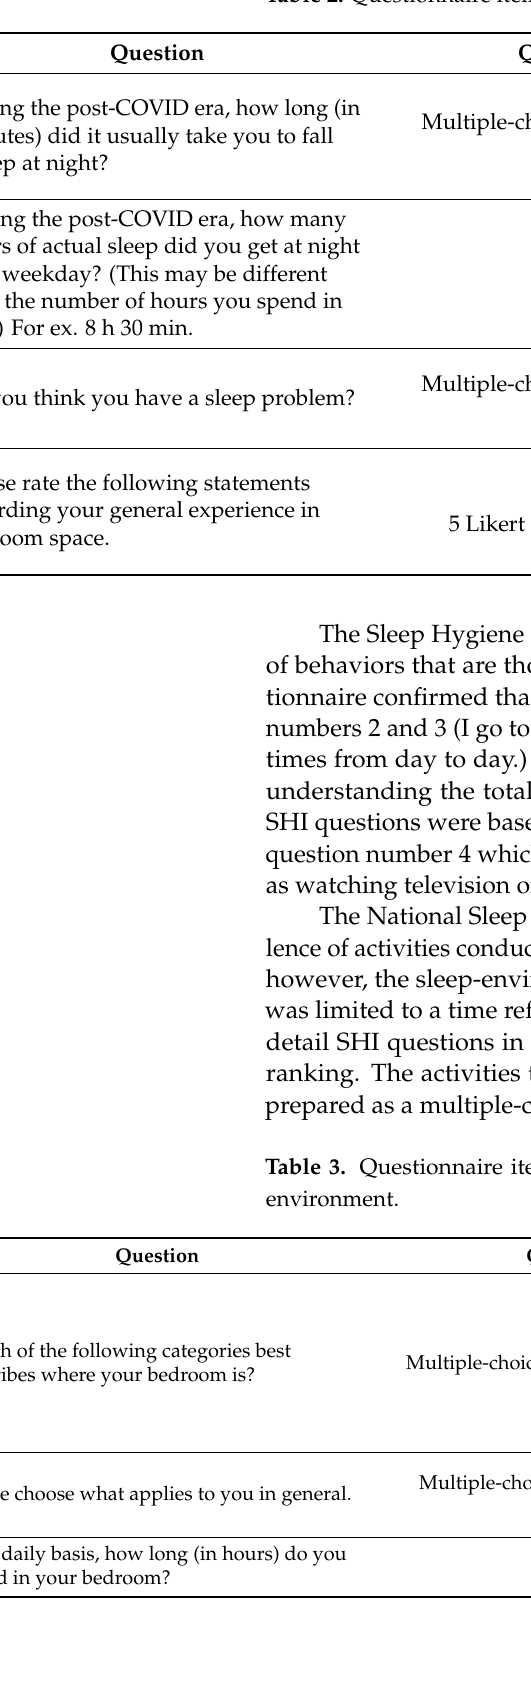
Table 2. Questionnaire items related to participants’ sleep habits.